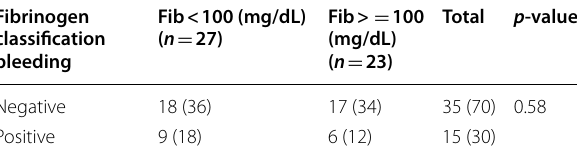
Table 6 Evaluation and comparison of mean fibrinogen levels